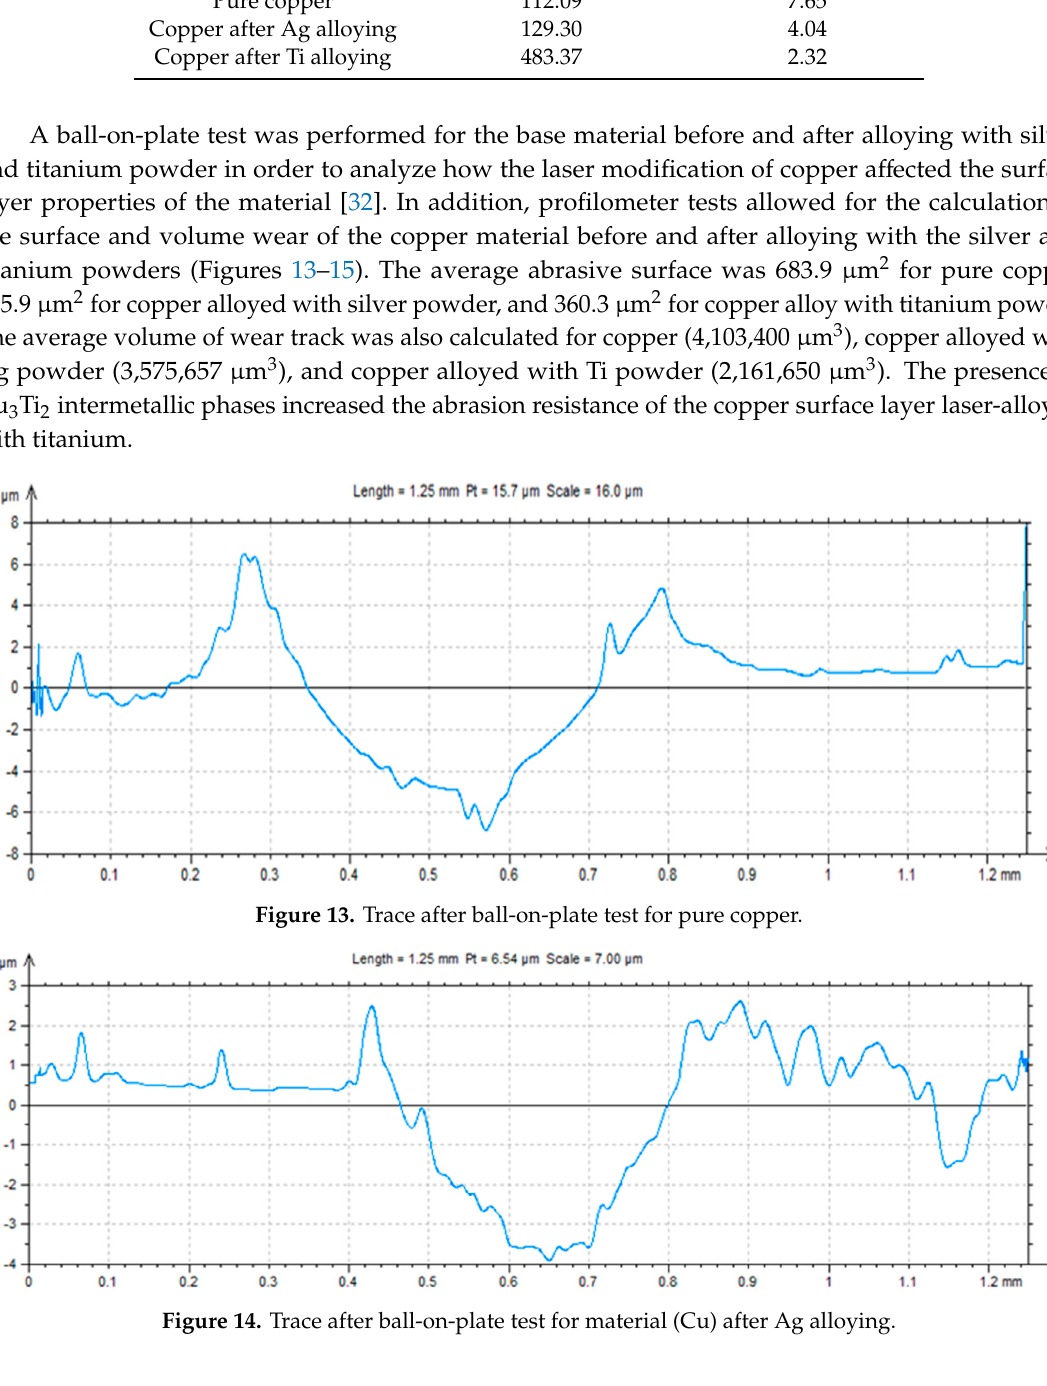
Figure 15. Trace after ball-on-plate test for material (Cu) after Ti alloying. The results of the conductivity test showed that the specific electrical conductivity of the material tested before the alloying process was higher than either case after treatment. The average conductivity for copper was 58.35 MS/m. In the case of copper alloyed with silver powder, the material average conductivity was 42.29 MS/m (standard deviation was 0.85), where a decrease by 27.5% was observed. 4. Conclusions Herein, we report the various impacts of laser modification of a copper surface with silver and titanium powder. Following such a treatment, a re-melting zone (RZ), a diffusion zone (DZ), and heat affected (HAZ) zone were identified in the materials after alloying with either powder tested. The diffusion zone was created between the re-melting zone and the heat affected zone, and there was no gap between the RZ and HAZ zones because the re-melting zone solidified in the direction of the surface.